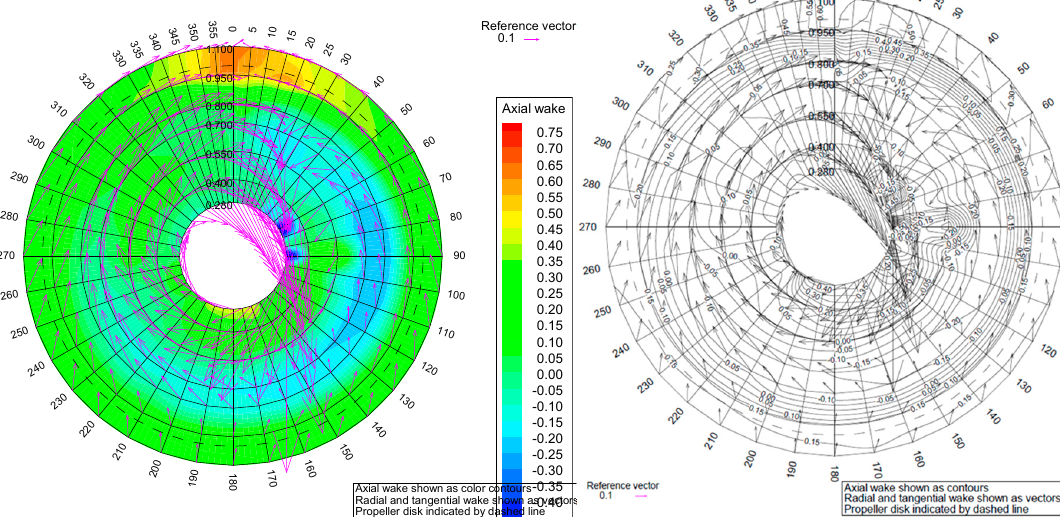
Figure 21. 3D wake measurements at a plane midway between the propeller and rudder, with a working propeller, without PSS, at 14 kn.